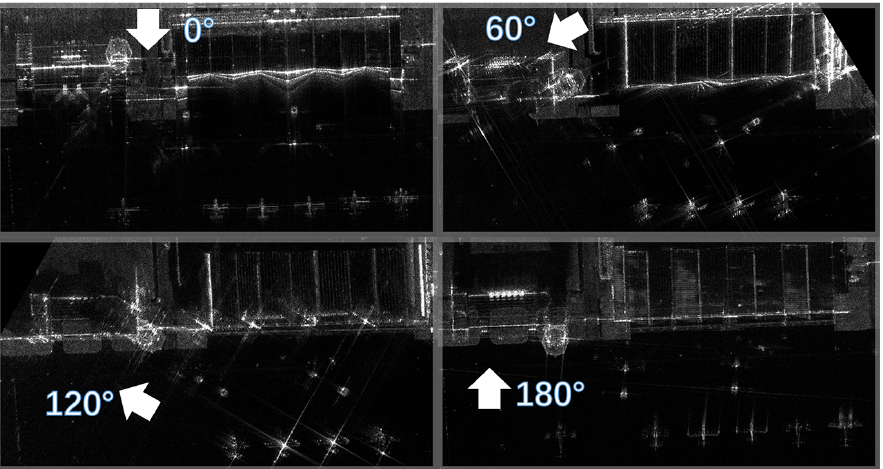
Figure 7. Example SAR images collected from 4 different aspects. Radar line of sight is indicated on each image with white